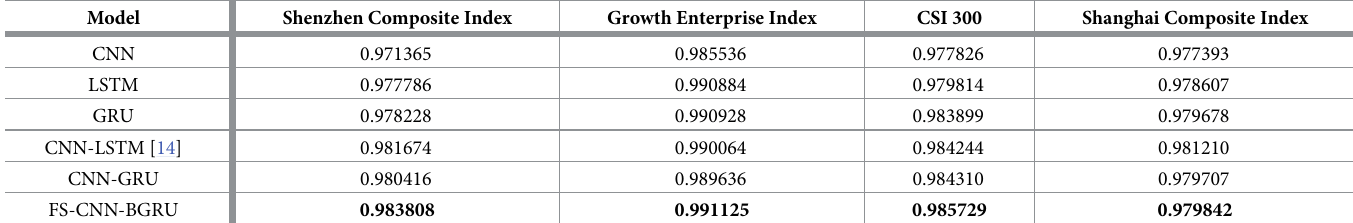
Table 13. R 2 of index stocks.